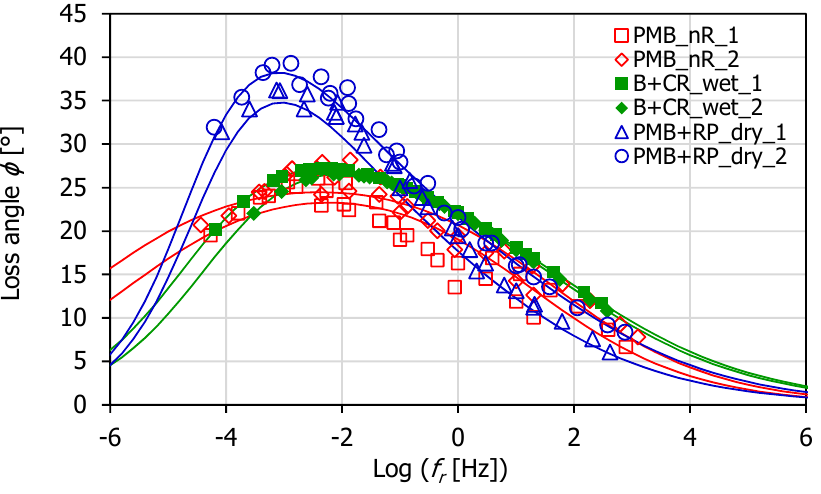
Figure 4. Master curves of the loss angle at 20 °C.